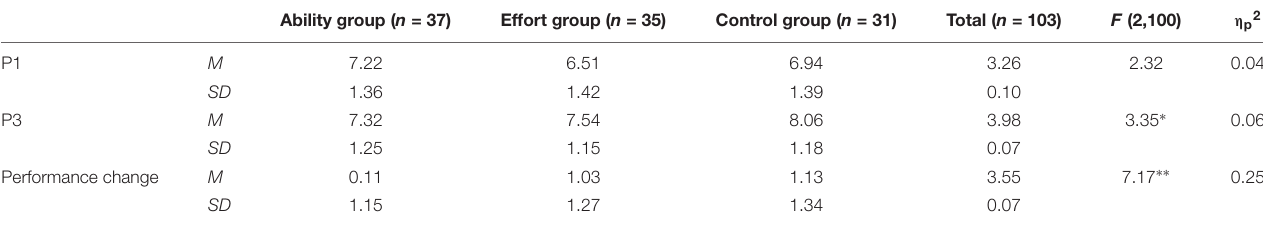
TABLE 4 | Descriptive statistics for children’s